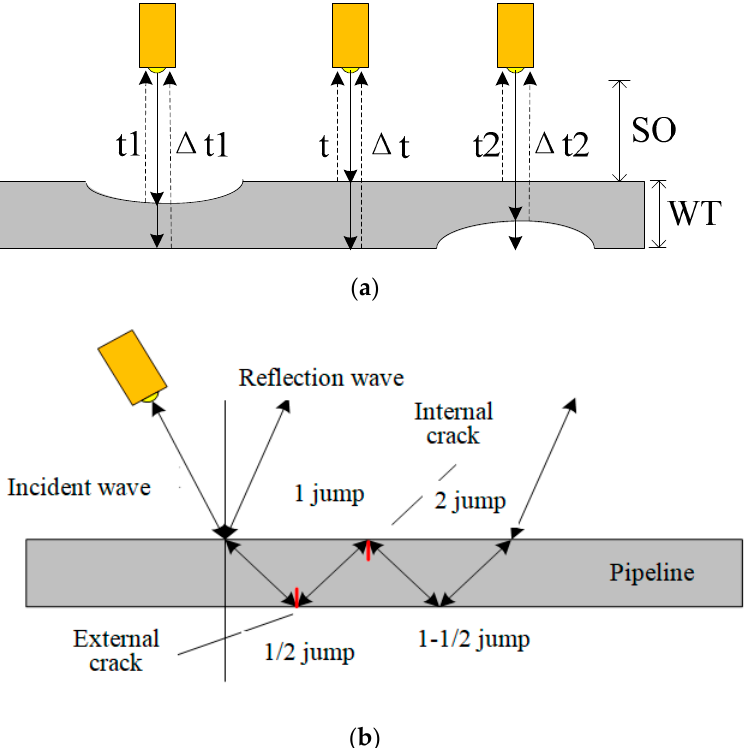
Figure 2. Principles of ultrasonic inspection: ( a ) principles of ultrasonic inspection for corrosion; ( b ) principles of ultrasonic inspection for cracking.